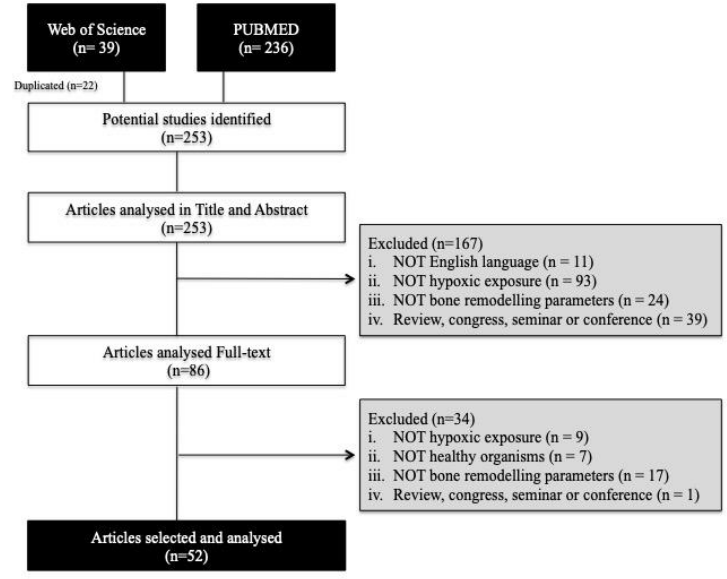
Figure 1. Flowchart of article searches and selection strategies.